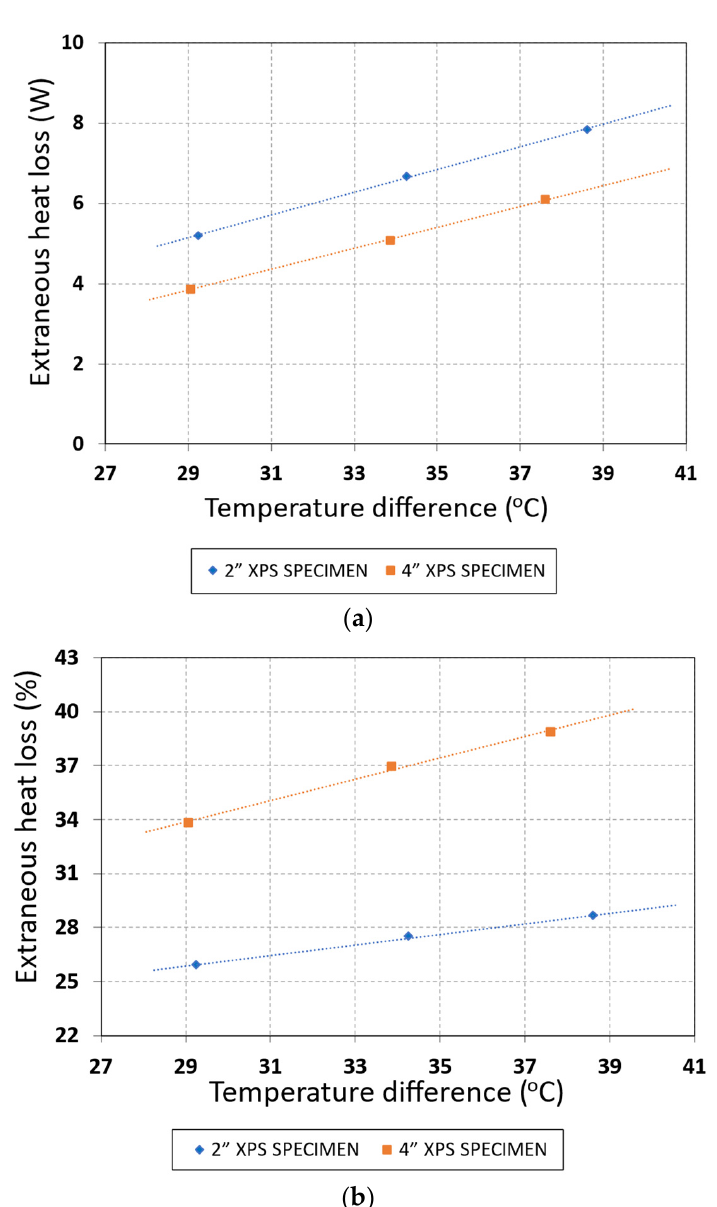
Figure 10. Relation between temperature gradients and extraneous heat loss as: ( a ) an amount; ( b ) a